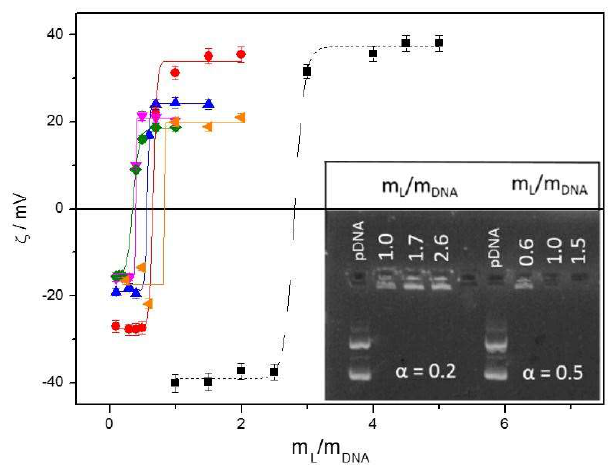
Figure 1. Plots of the zeta potential ( ζ ) against the m L / m DNA mass ratio in the C 3 (C 16 His) 2 /DOPE-pDNA lipoplexes at various mole fractions of the C 3 (C 16 His) 2 cationic lipid in the C 3 (C 16 His) 2 /DOPE mixed lipid ( α = 0.2, 0.4, 0.5, 0.6 and 0.7; red, blue, pink, orange and green, respectively) and of the C 3 (C 16 His) 2 /DOPE-ctDNA lipoplex at α = 0.5 (black). Inset: Electrophoresis agarose gel of the C 3 (C 16 His) 2 /DOPE-pDNA lipoplexes at various m L / m DNA mass ratios and α = 0.2 and 0.5.